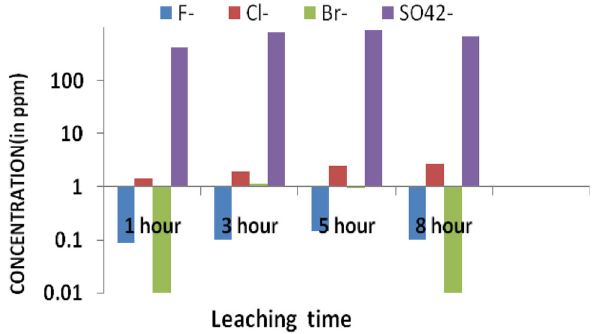
Fig. 21 Change in concentration (in ppm) of anions in aqueous leachates of Ledo OB (LOB-15A) with leaching time (in hour) at 65 (cid:3) C